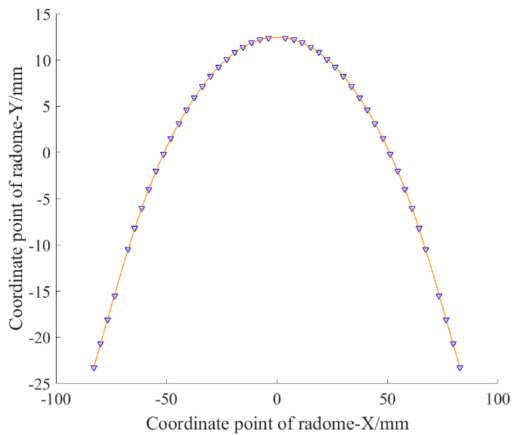
Figure 3. Fourier approximation fitting